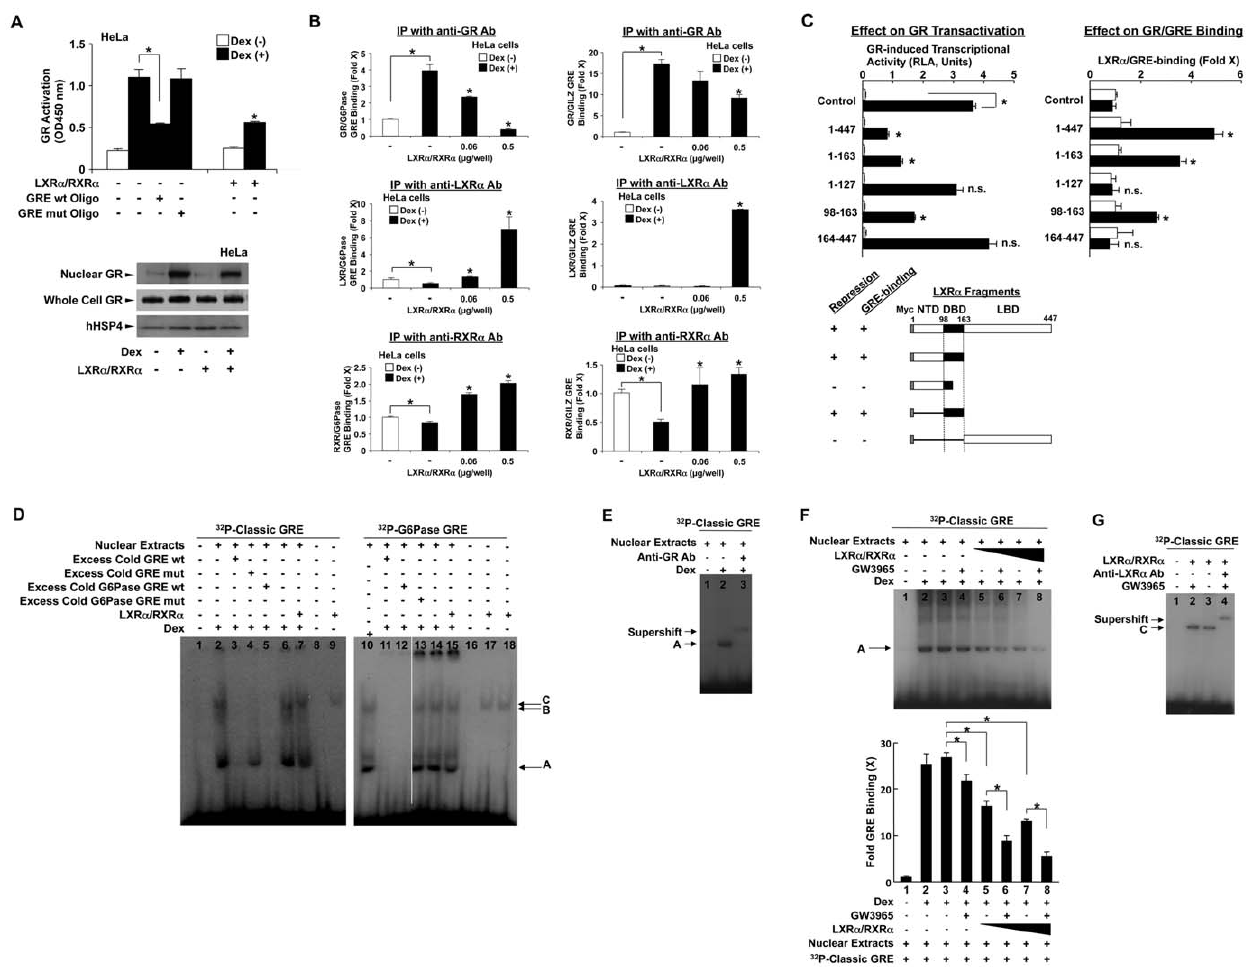
Figure 6. LXR a /RXR a attenuates the association of GR to GREs invitro and invivo . A. Upper panel : LXR a /RXR a suppresses association of the GR to its classic consensus GRE in vitro . HeLa cells were transfected with pCMX-hLXR a and pCMX-hRXR a , or their carrying plasmid pCMX, and were treated with or without 10 2 6 M dexamethasone for 2 hours. Nuclear extracts were harvested from the cells and the binding activity of GR to GREs was evaluated in the presence or absence of wild type (wt) or mutant (mut) GRE oligonucleotides (Oligos) using the TRansAM TM GR kit (Active Motif). Bars represent mean 6 S.E. values of the absorbance at 450 nm in the presence or absence of 10 2 6 M of dexamethasone. *: p , 0.01, compared to the condition transfected with the control plasmid in the presence of dexamethasone and in the absence of GRE Oligos or between the two conditions indicated. Dex: dexamethasone. Lower panel : Overexpression of LXR a /RXR a does not influence dexamethasone-induced translocation of GR from the cytoplasm into the nucleus. Nuclear extracts obtained from HeLa cells were run on 4–20% SDS-PAGE gels, blotted to nitrocellulose membranes and GR ( upper panel : nuclear GR, middle panel : whole cell GR) and hHSP4 ( lower panel ) were visualized with their specific antibodies in Western blots. B. LXR a /RXR a overexpression differentially affects the association of GR to its GREs in ChIP assays. HeLa cells were transfected with the empty control pCMX vector, or pCMX-hLXR a and -hRXR a , treated with or without 10 2 6 M dexamethasone, and ChIP assays were performed using anti-hGR a , anti- hLXR a and anti-hRXR a antibodies. Bars represent mean 6 S.E. values of the fold precipitation of G6Pase GREs ( left panel ) or GILZ GREs ( right panel ) determined in the SYBR Green-based real-time PCR. *: p , 0.01, n.s.: not significant, compared to the condition transfected with the control plasmid in the presence of dexamethasone or between the two conditions indicated. Dex: dexamethasone, IP: immunoprecipitation. C. DBD of LXR a confers LXR a -mediated repression of GR transcriptional activity and binding to G6Pase GREs. HCT116 cells were transfected with pRShGR a together with pMMTV-Luc and pGL4.73[ hRluc /SV40], pCMX-hRXR a and the pCDNA3-6myc plasmid expressing wild type LXR a (1–447) or indicated LXR a mutants. Cells were incubated in the presence (black columns) or absence (white columns) of 10 2 6 M dexamethasone. Using aliquots of cell lysates, luciferase assays were performed. ChIP assays were also performed by treating cells with 4% formaldehyde, and by precipitating LXR a /G6Pase GREs with anti- Myc-antibody. Bars represent mean 6 S.E. values of the firefly luciferase activity normalized for the renilla luciferase activity ( left panel ) or of the fold precipitation of G6Pase GREs ( right panel ) determined in the SYBR Green-based real-time PCR in the presence or absence of 10 2 6 M dexamethasone. *: p , 0.01, n.s.: not significant, compared to the condition treated with dexamethasone in the absence of LXR a /RXR a or between the two conditions indicated. NTD: N-terminal domain, DBD: DNA-binding domain, LBD: ligand-binding domain. D, E, F, G. LXR a /RXR a heterodimer binds to classic consensus and G6Pase GREs in gel mobility shift assays and reduces GR binding to its GREs. D. Nuclear extracts from HeLa cells or LXR a /RXR a recombinant proteins were incubated with 32 P-labeled classic consensus GRE ( left panel ) or G6Pase GRE ( right panel ) with dexamethasone (Dex) in the presence or absence of an excess amount (50-fold molar excess) of unlabeled classic consensus GRE wild type (wt), GRE mutated (mut), G6Pase GRE wt, or G6Pase GRE mut. E. Nuclear extracts from HeLa cells were incubated with 32 P-labeled classic consensus GRE in the presence or absence of dexamethasone (Dex) and in the presence or absence of anti-GR antibody (Anti-GR Ab). F. Nuclear extracts from HeLa cells were incubated with 32 P- labeled classic consensus GRE in the presence or absence of dexamethasone (Dex) and/or GW3965 under the presence of increased amounts of LXR a /RXR a recombinant proteins ( upper panel ). The intensities of band A from 3 independent experiments including that shown in the upper panel were measured with the image J software and fold GRE binding was calculated by comparing to control (lane 1) ( lower panel ). Bars represent mean 6 S.E. values of fold GRE binding from 3 independent experiments. *: p , 0.01, compared to the conditions indicated. G. LXR a /RXR a recombinant